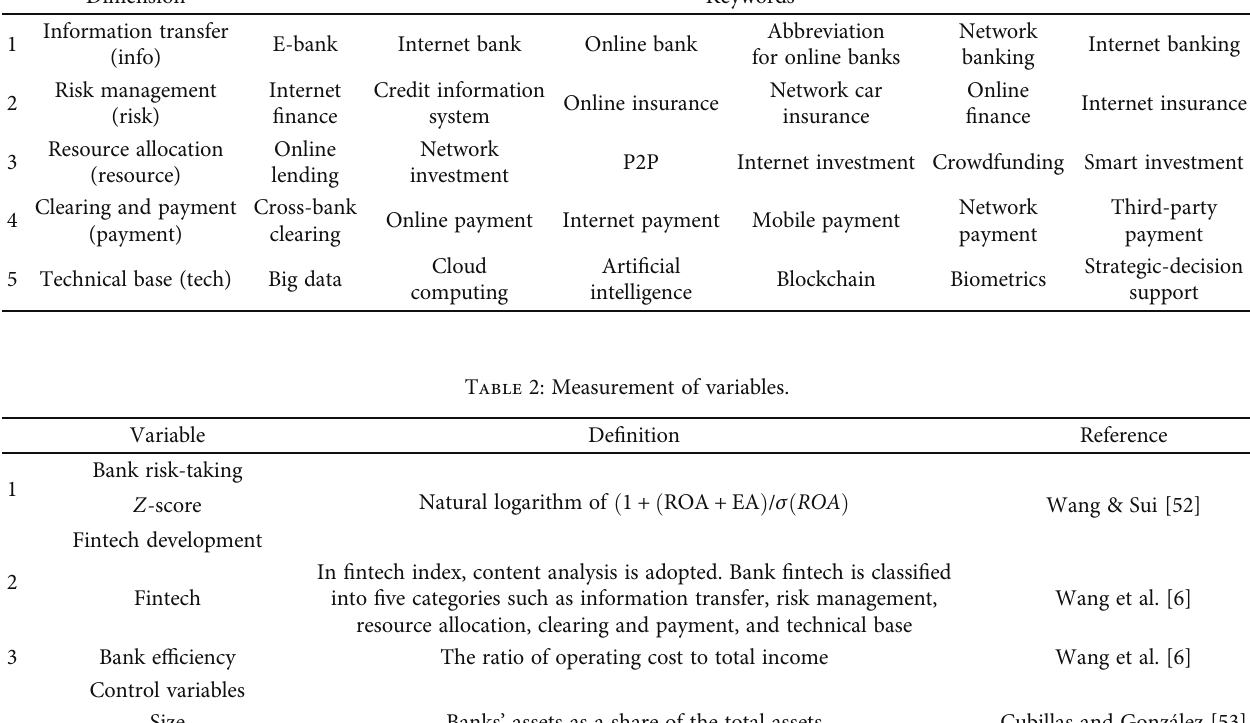
Table 1: Fintech keywords.